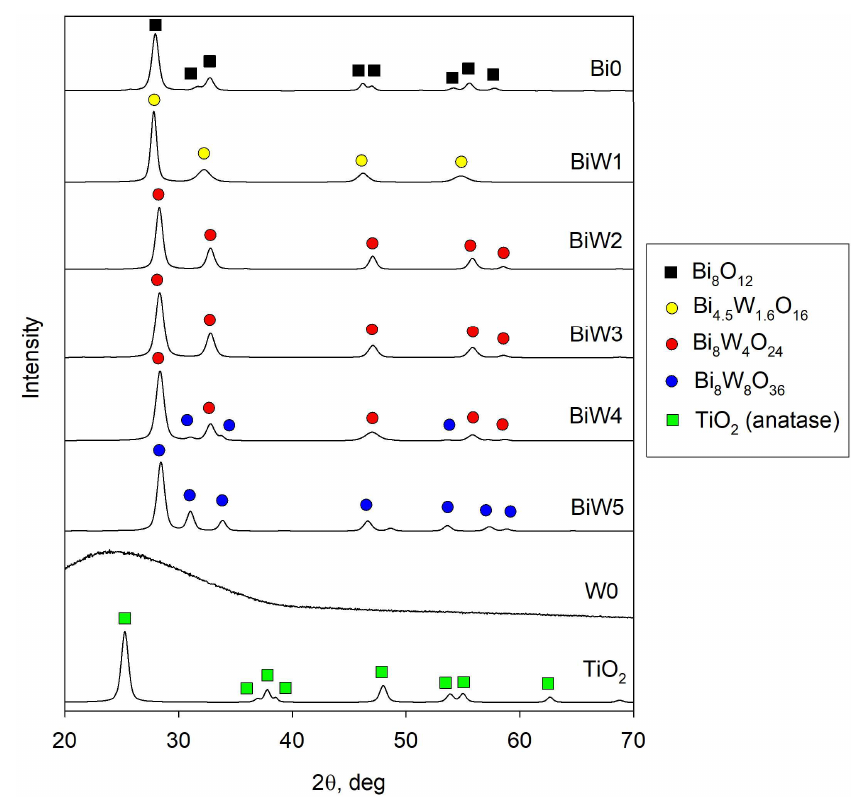
Figure 3. XRD patterns of coatings deposited onto 2-mm glass beads and annealed at 673 K.